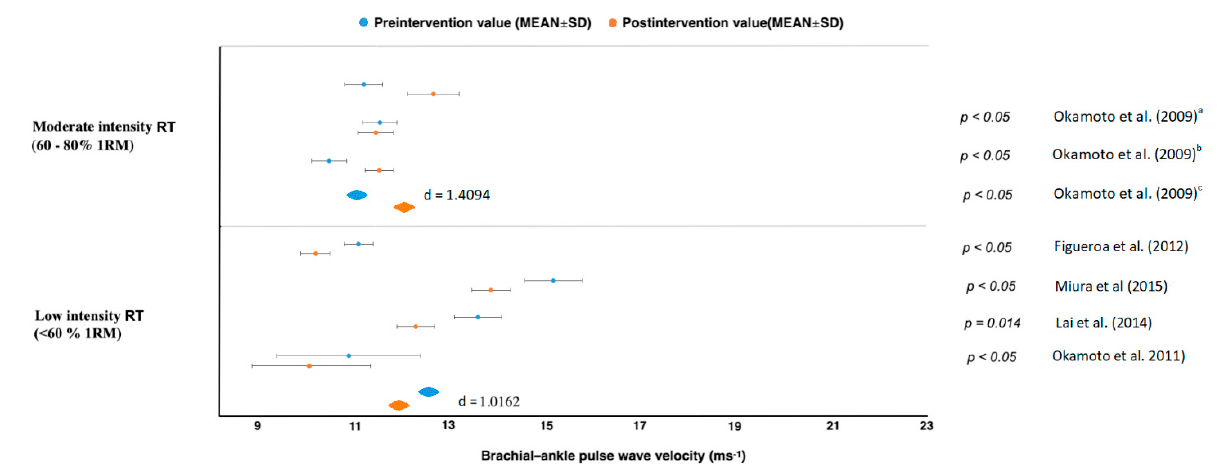
Figure 4. Femoral–ankle pulse wave velocity changes. RM = repetition maximum, SD = standard deviation.